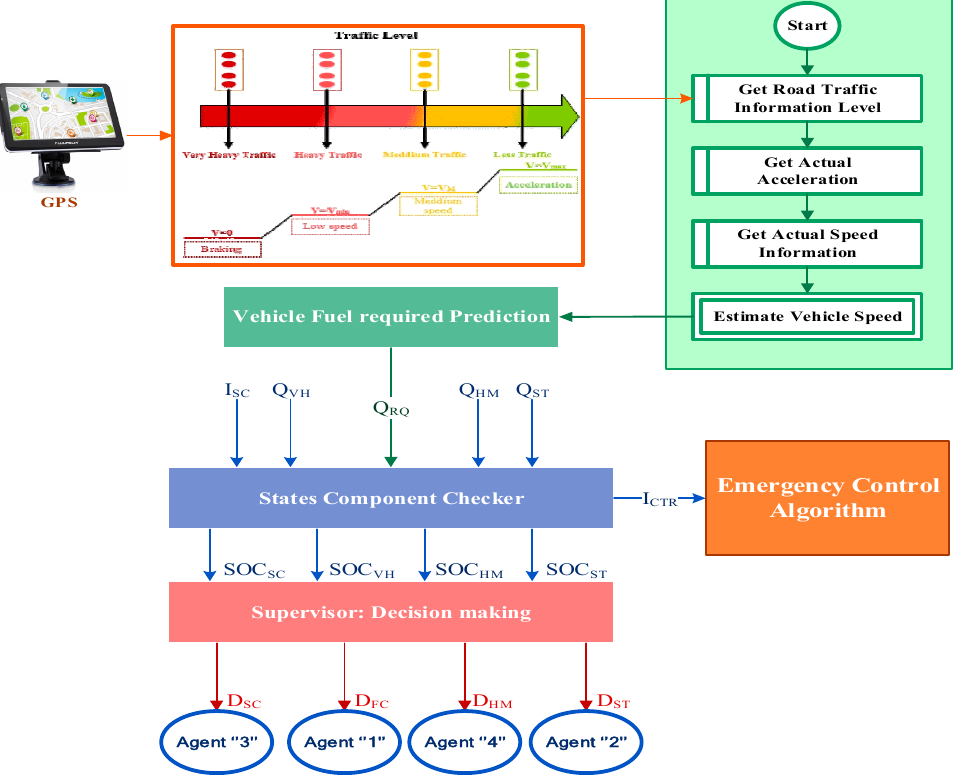
Figure 3. Vehicle control based on fuel prediction.